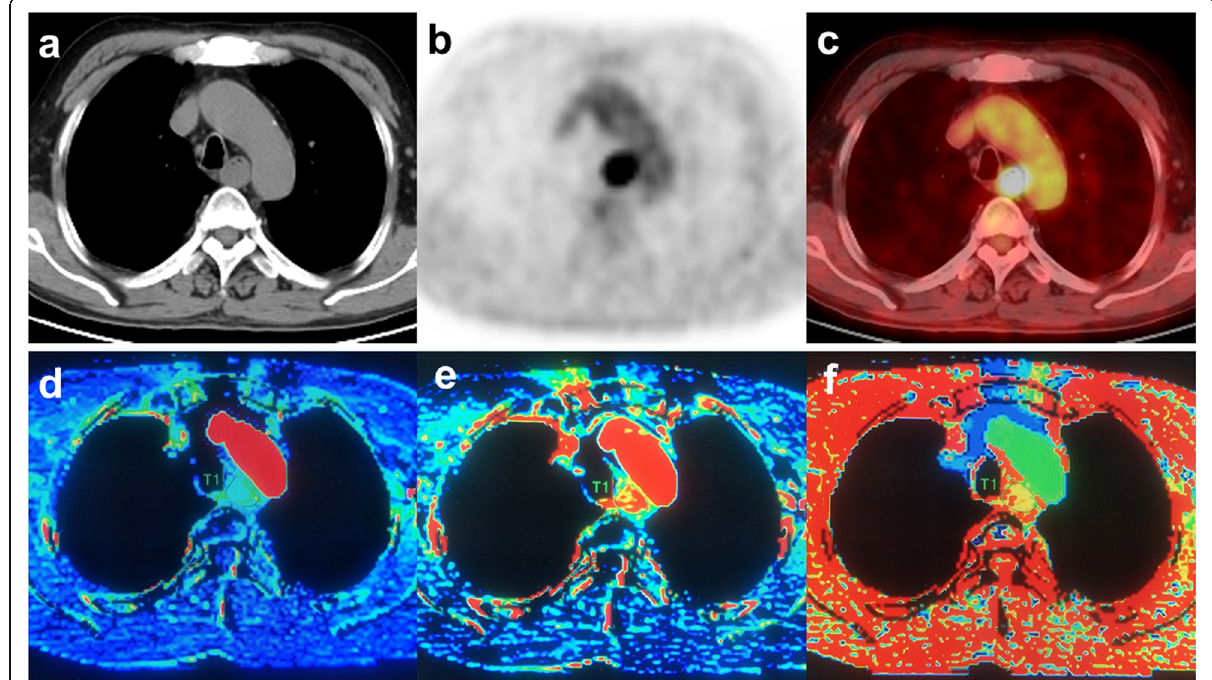
Fig. 1 A 75-year-old man with a squamous cell carcinoma in the upper thoracic portion ofesophagus. a CT image. b PET image. c Fused axial PET/CT image (SUVmax, 14.57; MTV, 16.32 mL; TLG, 92.91). d BF (47.3 mL/min/100 g). e BV (20.2 mL/100g). f TTP (16.7